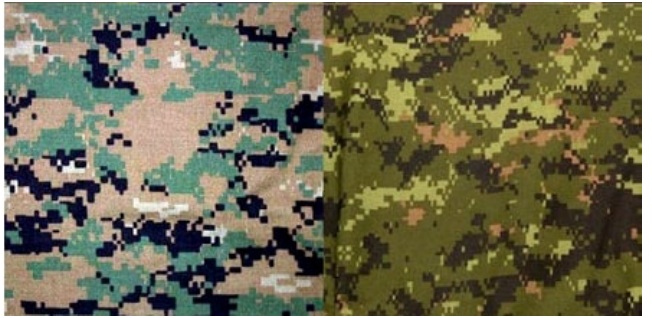
Figure 4. Examples of pixel camouflages: MARPAT on the left , CADPAT on the right